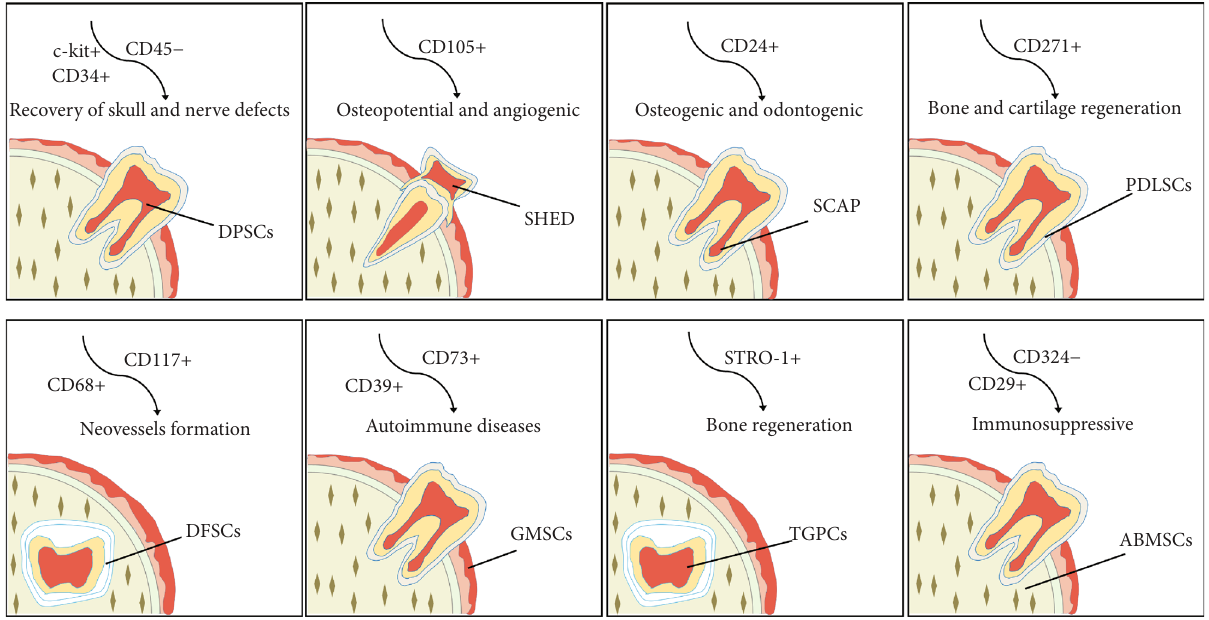
Figure 1: Schematic drawing demonstrating sources and markers of human dental stem cells with clinical application potential. DPSCs: dental pulp stem cells; SHED: stem cells from human exfoliated deciduous teeth; SCAP: stem cells from the apical papilla; PDLSCs: periodontal ligament stem cells; DFSCs: dental follicle stem cells; GMSCs: gingiva-derived mesenchymal stem cells; TGPCs: tooth germ progenitor cells; ABMSCs: alveolar bone-derived mesenchymal stem